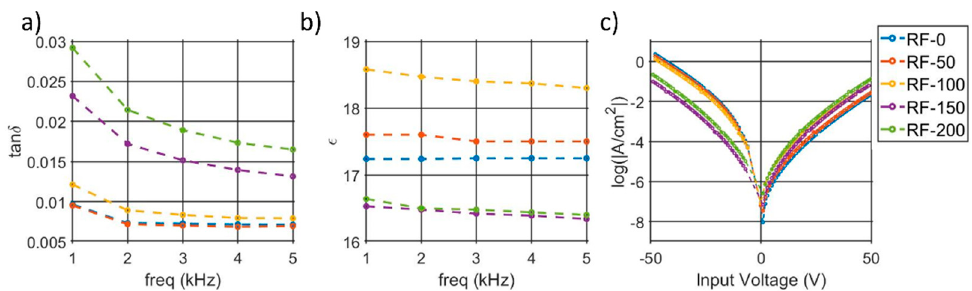
Figure 4. ( a ) Dielectric losses and ( b ) dielectric permittivity measured from 1 to 5 kHz. ( c ) Leakage current density of the non-switching sweep.